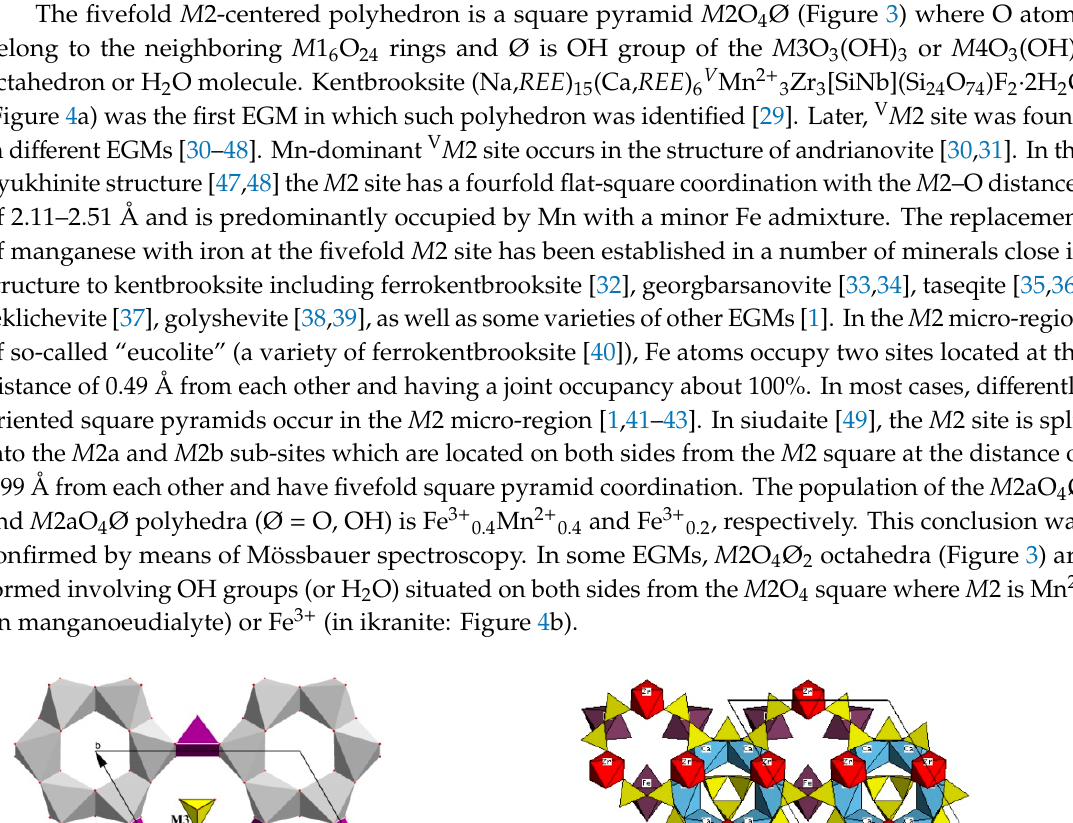
( c ) Figure 5. Local situations at the centers of the Si 9 O 27 rings viewed along (001). ( a ) A ring with vacancy at the M 3 site, ( b ) a ring centered with the SiO 4 tetrahedron, ( c ) a ring centered with the NbO 6 octahedron. Three O atoms which form the base of each Si-centered tetrahedron occurring in the M 3 or M 4 micro-region are common with O atoms of the Si 9 O 27 ring. The fourth O atom of this tetrahedron belongs to OH group. The M 3, M 4 Si atoms can occur either above or below the triangular base of the